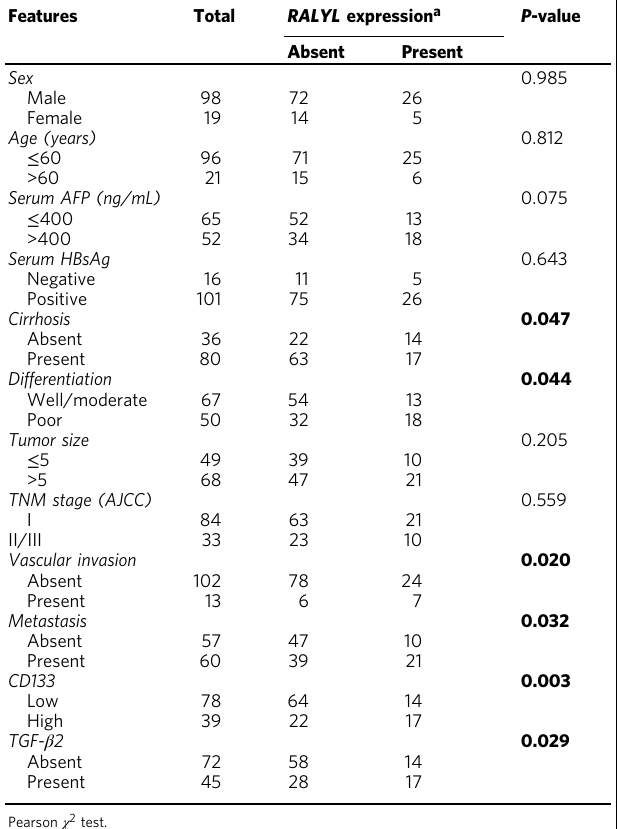
Table 1 Association between RALYL expression and clinicopathologic features in 117 HCC cases. Features